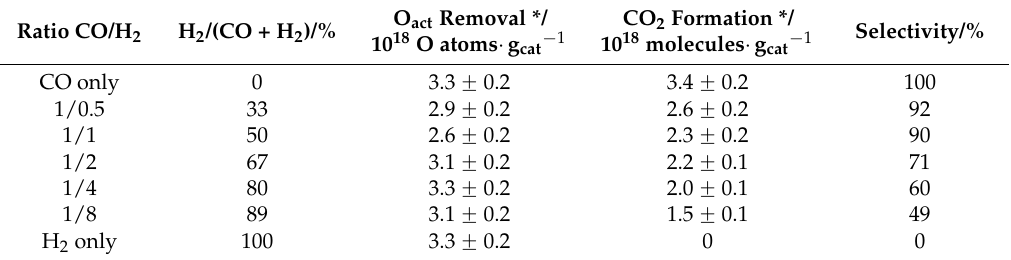
Table 1. Absolute amounts of active stable oxygen (O act ) removal and CO 2 formation during CO, H 2 , and CO/H 2 pulses with different CO/H 2 ratios on the fully oxidized Au/TiO 2 catalyst at 80 ˝ C, and corresponding selectivities for CO oxidation.